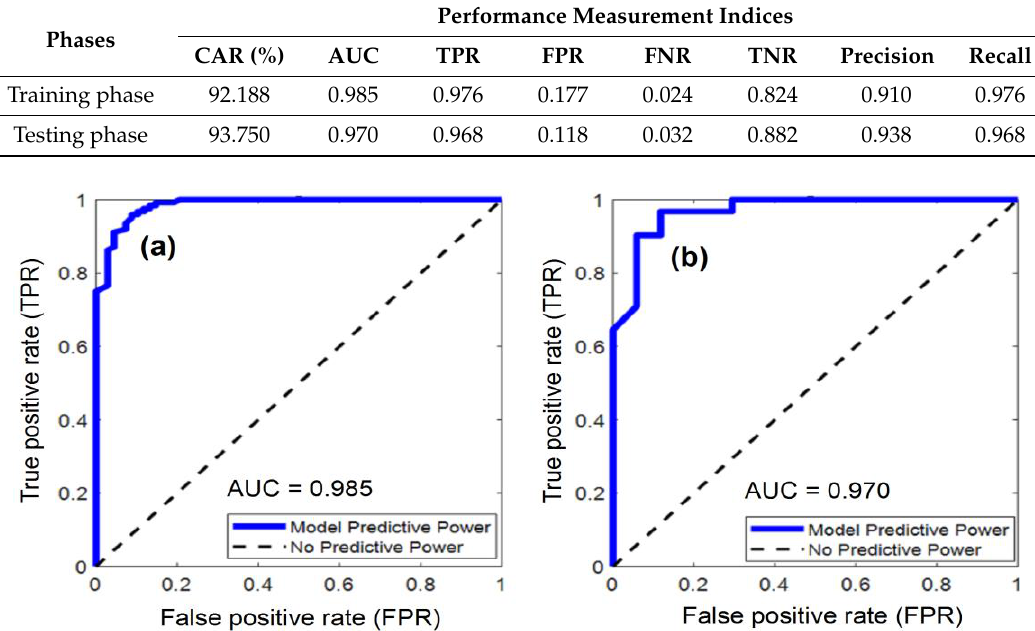
Figure 11. ROCs of the proposed FA-LM-ANN model: ( a ) training phase; ( b ) testing phase.